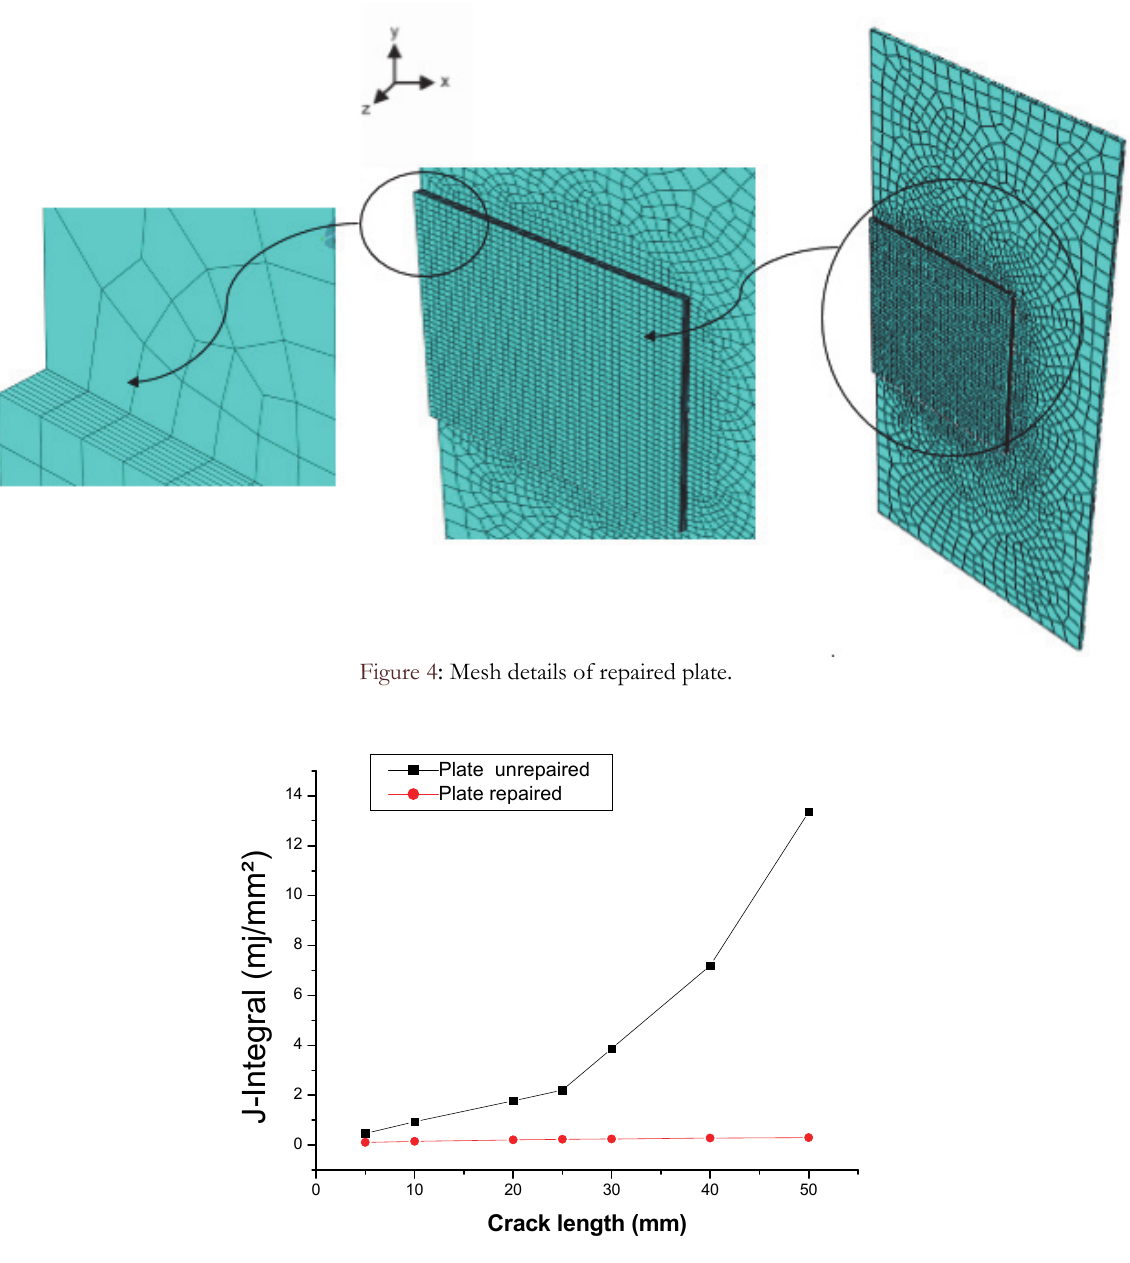
Figure 5: Variation of the J-Integral as a function of the length of the crack to the damaged plates and repaired by composite